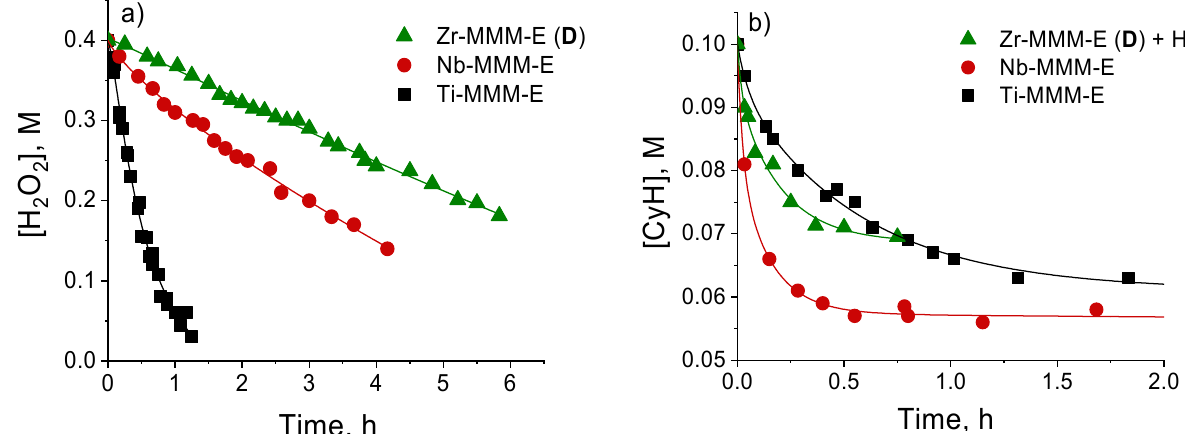
Figure 11. Comparison of catalytic activity of Zr-MMM-E, Nb-MMM-E and Ti-MMM-E in ( a ) H 2 O 2 decomposition (reaction conditions: H 2 O 2 0.4 M, catalyst 0.016 mmol of Zr, Nb or Ti, 70 °C, CH 3 CN 5 mL) and ( b ) CyH oxidation (reaction conditions as in Table 2, catalyst 0.003 mmol of Zr, Nb or Ti).